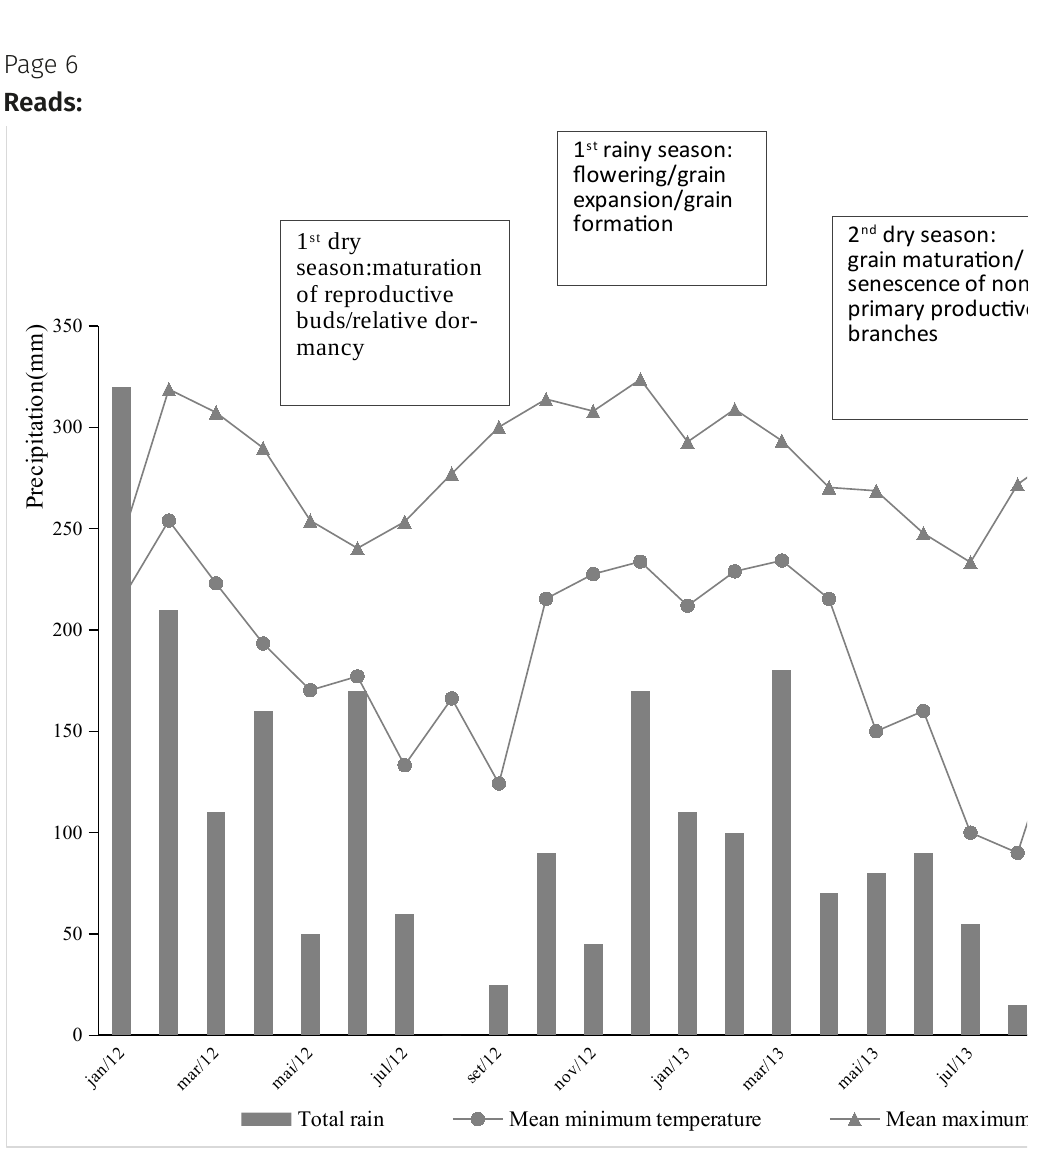
Figure 1. Monthly minimum and maximum mean air temperatures, rainfall distribution and phenological stage of coffee plants in FACE